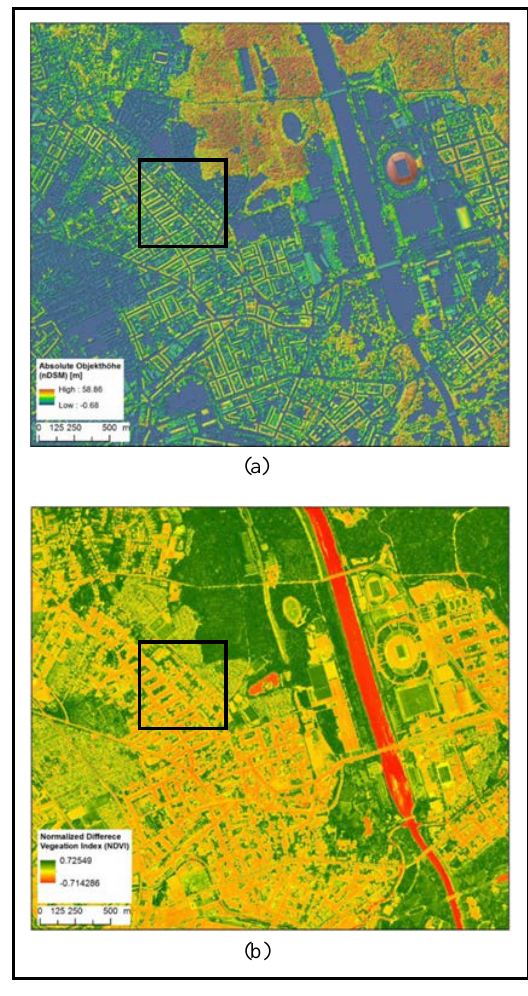
Figure 2. Display of preprocessed input data (a) the absolute height above ground, (b) the NDVI, both depicting an extraction of the study area: Wilhelmenian style residential buildings (1870-1920) in the west and east, the river “Weiße Elster” from south to north next to the stadium, and the floodplain forest in the northern